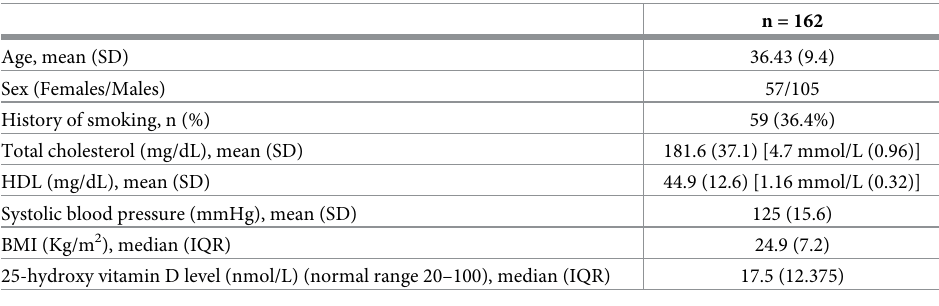
Table 1. Characteristic of study